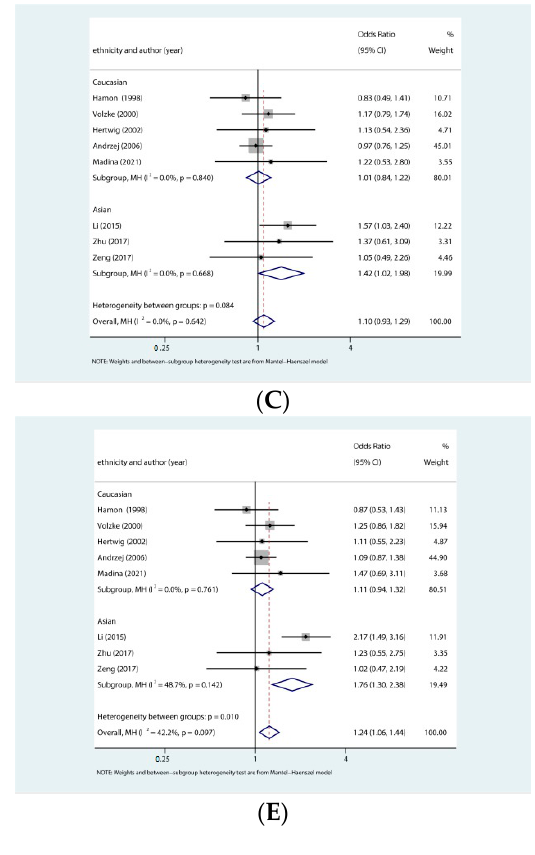
Figure 4. Sensitivity analysis of the pooled OR coefficients on the relationship between rs5186 pol- ymorphism and risk of restenosis after PCI.CI = confidence interval, OR = odds ratio [13–20].